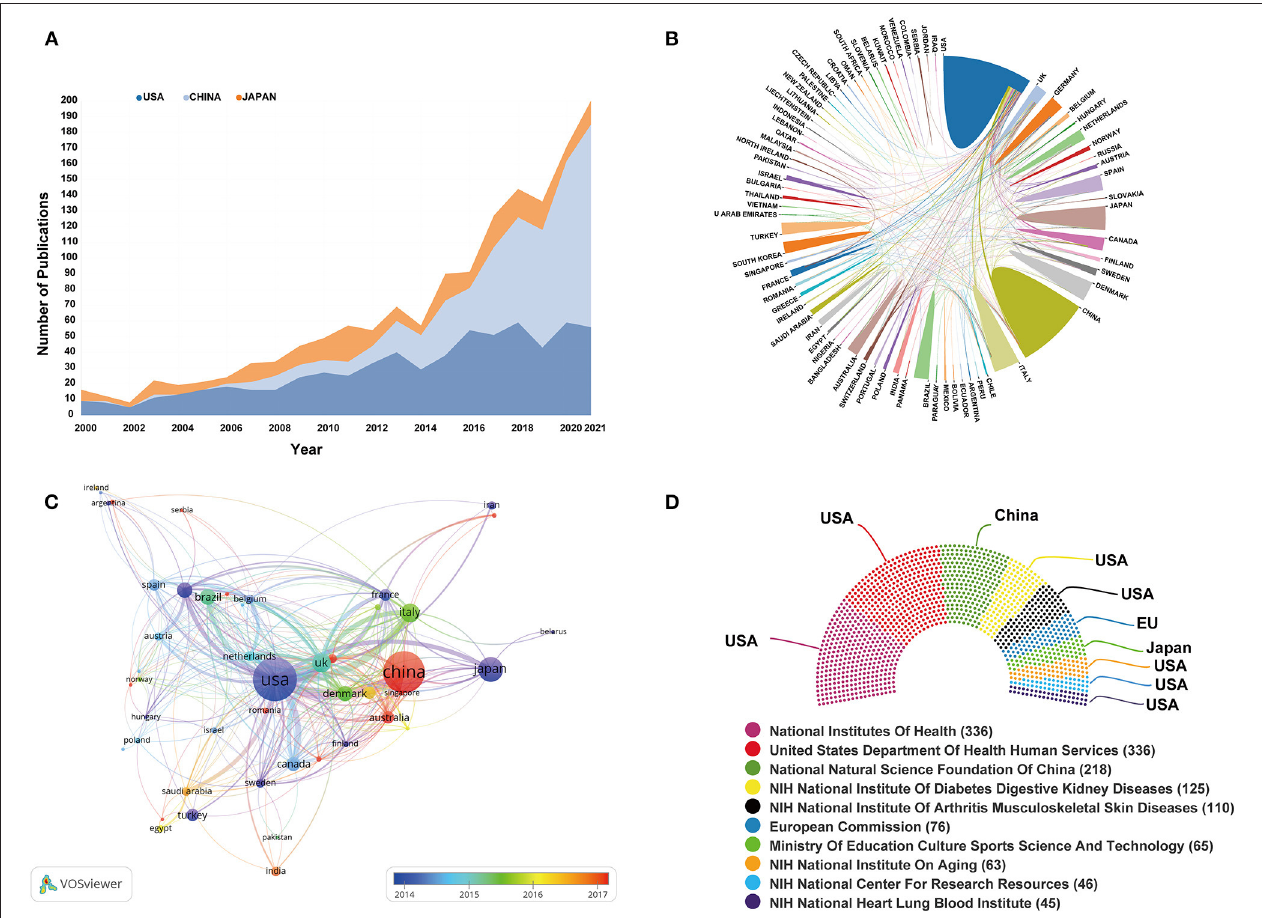
FIGURE 3 | (A) The annual publications of the top 3 countries from 2000 to 2021. (B) The international cooperation analysis among different countries. Line thickness between countries reflects the intensity of the closeness. (C) The overlay visualization map of country co-authorship analysis conducted by VOSviewer. Each country is represented as a node, and the node size is proportional to the sum of publications. A link between two nodes indicates a co-authorship relationship. Different nodes were given different colors (based on AAY) according to the color gradient in the lower right corner. (D) The top 10 most frequent funding sources in this